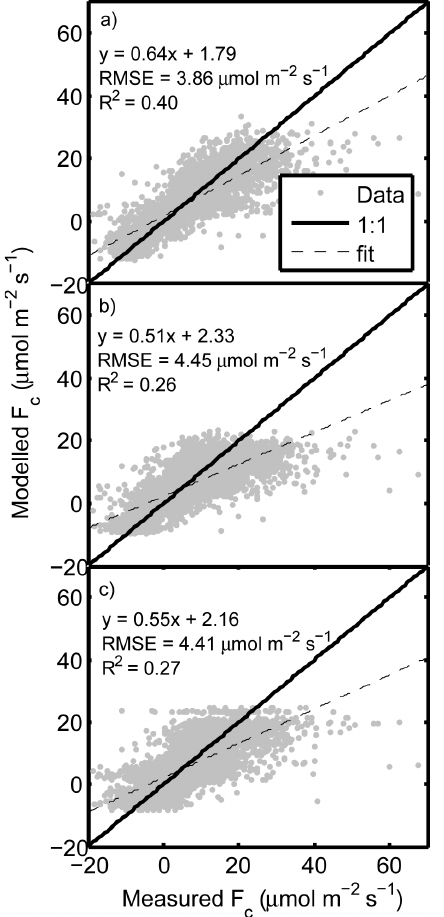
Fig. 7. The performance of the different gap filling methods for the independent dataset ( N = 11516): (a) is the ANN with traffic rates included, (b) the ANN without traffic rates and (c) the median diur- nal cycle method.